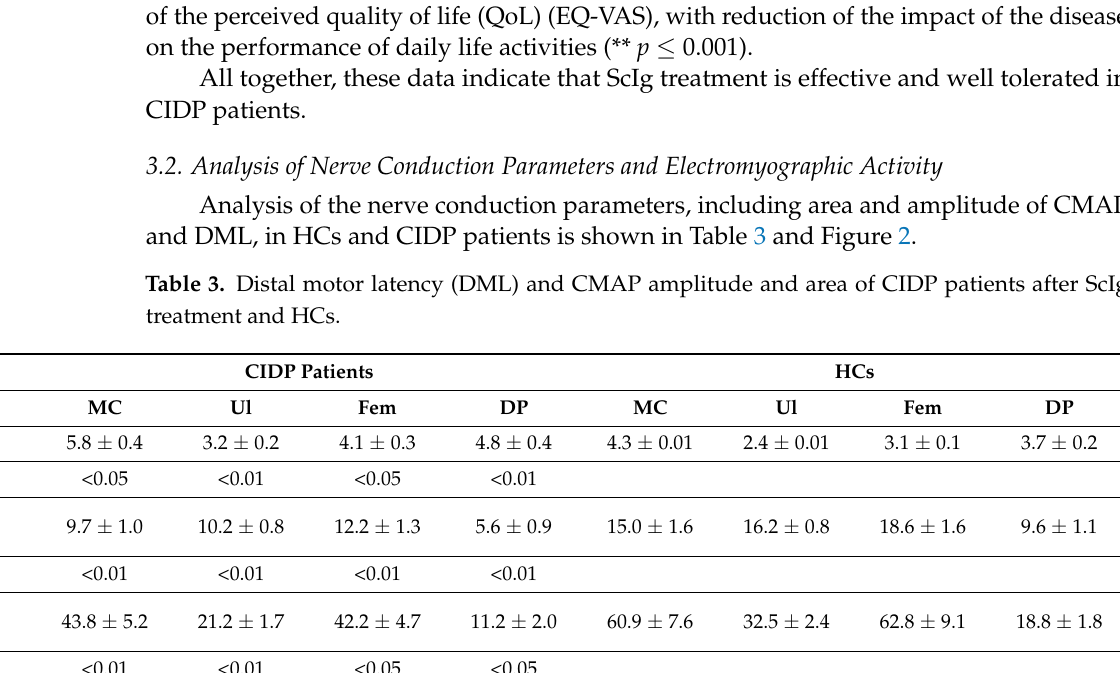
Table legend. CIDP: chronic inflammatory demyelinating polyneuropathy; HCs: healthy controls; MC: right musculocutaneous; Ul: left ulnar; Fem: left femoral; DP: right deep fibular; DML: distal motor latency; CMAP: compound muscle action potential; CIDP patients vs.